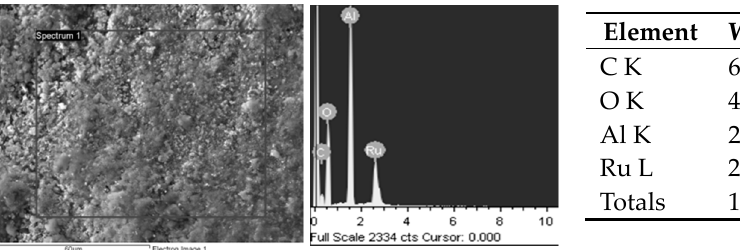
Figure 1. FE-SEMEDX micrographs of fresh 5 wt% Ru / Al 2 O 3 showing catalyst morphology and EDX analysis recorded on an area of the picture.